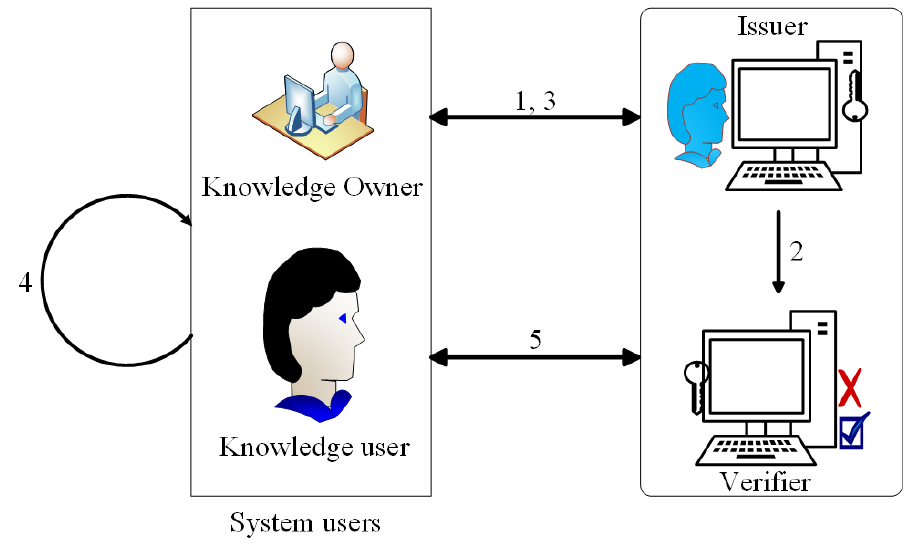
Figure 3. User registration and authentication